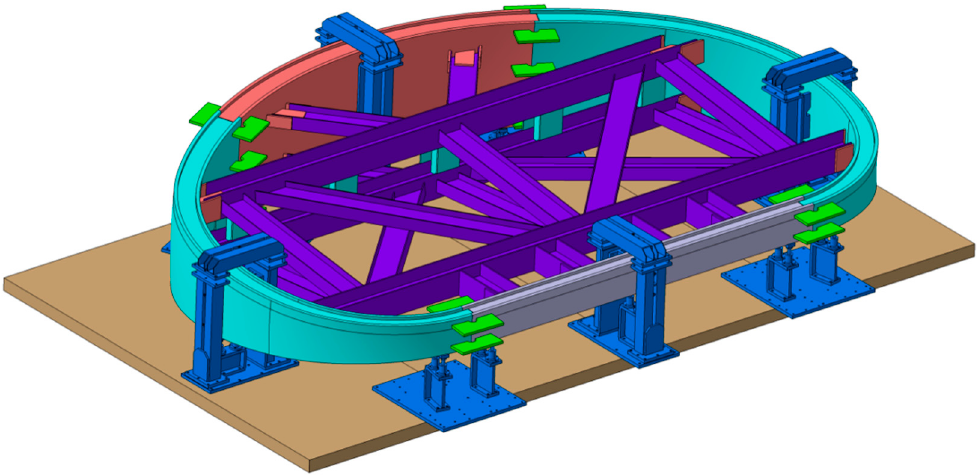
Figure 15. Constraint conditions in the practical production process of the 1/32 VV mock-up.